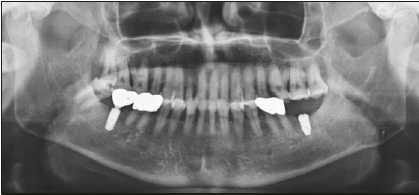
Figure 5: Preoperative radiographic view (panoramic X-ray image). Implantsofrightmaxillaareashowaseverealveolarbonelosslesion. (Dentium, Seoul, Korea) to secure vertical height (Figures 7 and 8(c)). Four months after this treatment, two implants were reinstalled at first premolar and first molar regions (Figure